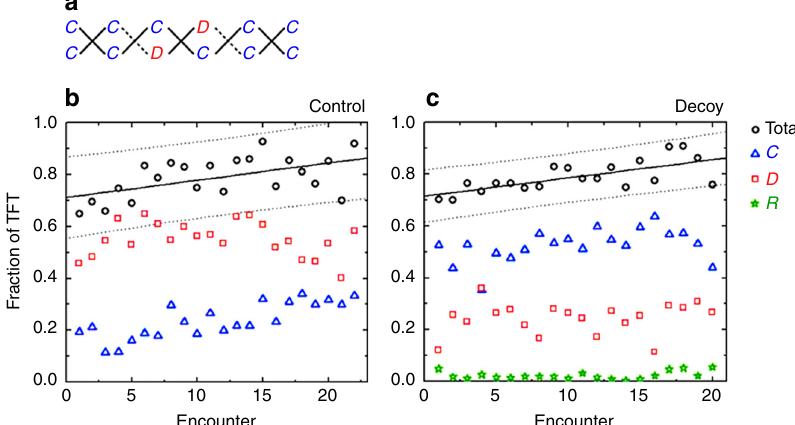
Fig. 4 Tit-for-tat (i.e., conditional cooperation) is the prevailing strategy. a To calculate the fraction of tit-for-tat (TFT) actions, we looked at each encounter individually and added all instances in which C was followed by C , D by D , or — when available — R by R (solid lines). This sum was then divided by the total number of possible TFT actions (solid and dashed lines), which equals 2× (number of rounds − 1). In the present example, the fraction of TFT actions is ¼ 0 : 8. b The average fraction of TFT actions in the control treatment is high from the beginning and slowly increases over the course of 20 + encounters 4 5 (intercept 0.711, 95% con fi dence interval [0.681 – 0.742]; slope 0.007, 95% con fi dence interval [0.004 – 0.009]; coef fi cient of determination R 2 = 0.292). Also shown is a breakdown of how much C and D contribute to the total fraction of TFT actions. c The average fraction of TFT actions in decoy and control treatments is similar (intercept 0.715, 95% con fi dence interval [0.694 – 0.735]; slope 0.007, 95% con fi dence interval [0.005 – 0.009]; coef fi cient of determination R 2 = 0.485). In the decoy treatment, however, the contribution of cooperative TFT actions is considerably higher than in the control treatment. Reward R contributes very little. Solid lines represent the ordinary least squares regression, whereas dashed lines are the corresponding 95% prediction con fi dence intervals